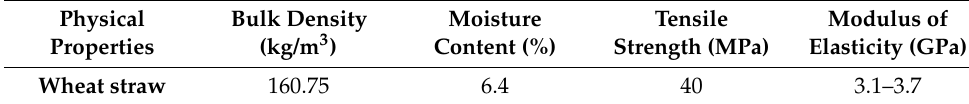
Table 1. Natural fiber properties of WS